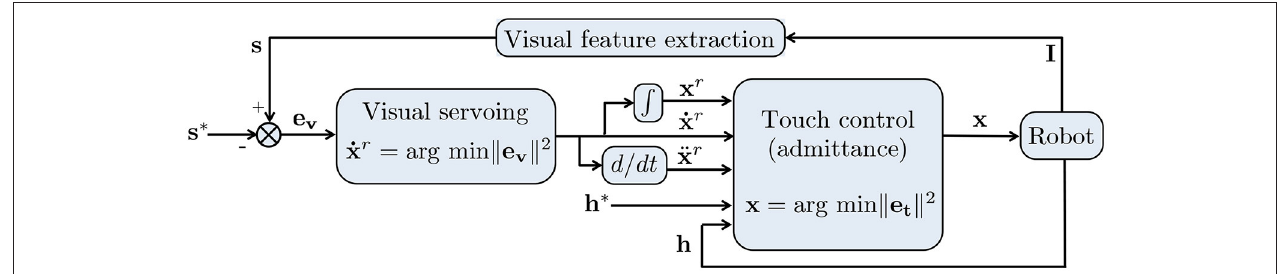
FIGURE 3 | The most common scheme for shared vision/touch (admittance) control, used in Morel et al. (1998), Agravante et al. (2013, 2014). The goal is to obtain desired visual features s ∗ and wrench h ∗ , based on current image I and wrench h . The outer visual servoing loop based on error (3) outputs a reference velocity ˙ x r that is then deformed by the inner admittance control loop based on error (8), to obtain the desired robot position x